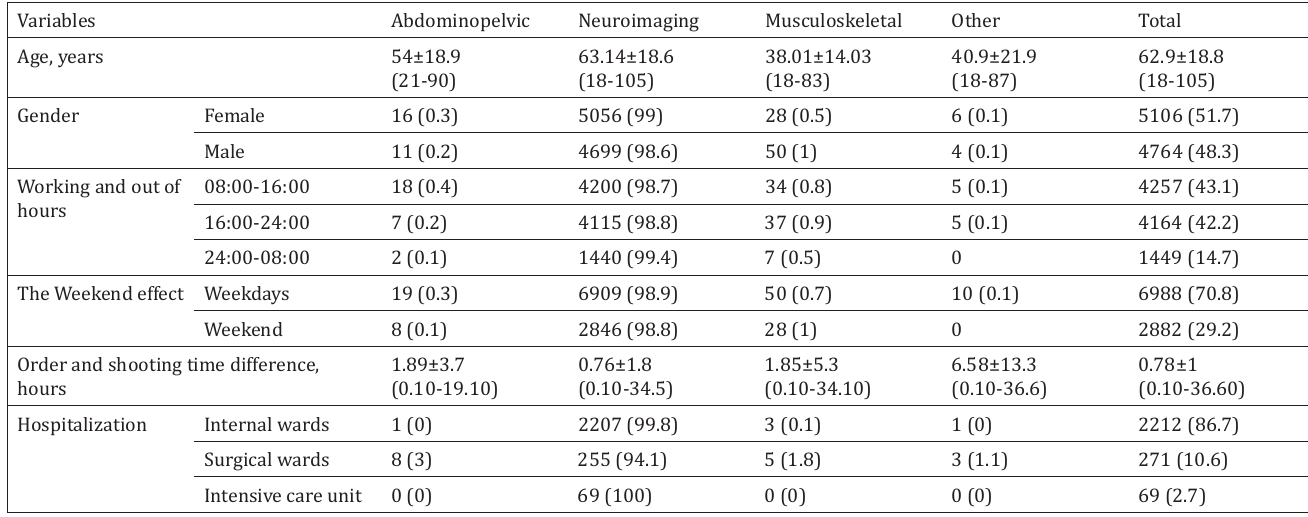
ED= emergency department; MRI= magnetic resonance imaging; The results are expressed as mean±standard deviation (SD) (min-max), or number and percent